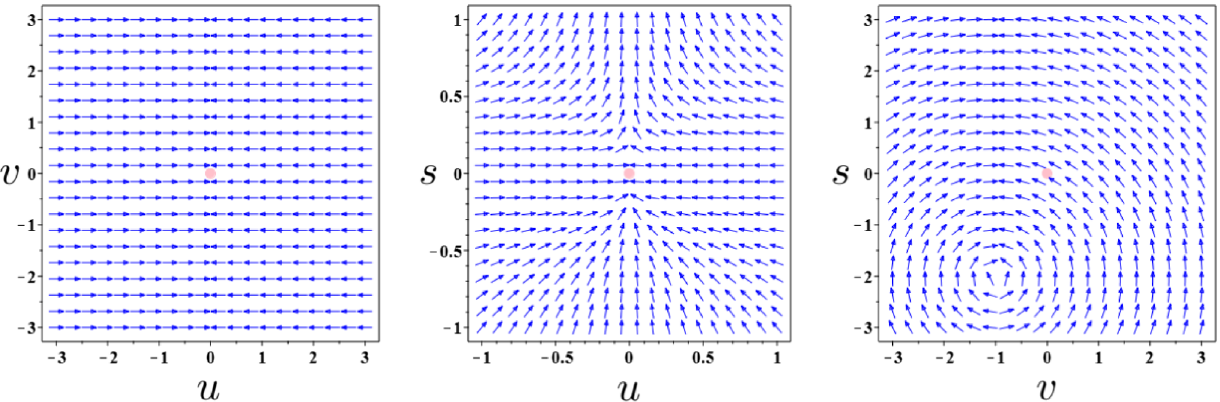
Fig. 7 This figure indicates three different Poincaré sections of phase space of the system (167)–(169). In plotting these portraits, we have taken κ 2 = 1, A = 1, m = 1, and α = 1. The pink points represent the critical points 3 where m 3 is an arbitrary constant, and (cid:11) = ± 1. However, both (cid:11) = + 1 and (cid:11) = − 1 are acceptable from a mathematical point of view, but only (cid:11) = + 1 is acceptable from a physical perspective. Besides this condition, one must have AB ≤ 0, A (cid:3)= 0, and m 3 > 0 to maintain these CPs in the physical region. The corresponding EoS parameter at the CP-plane turns out to be | = − 1 . w eff . CPs